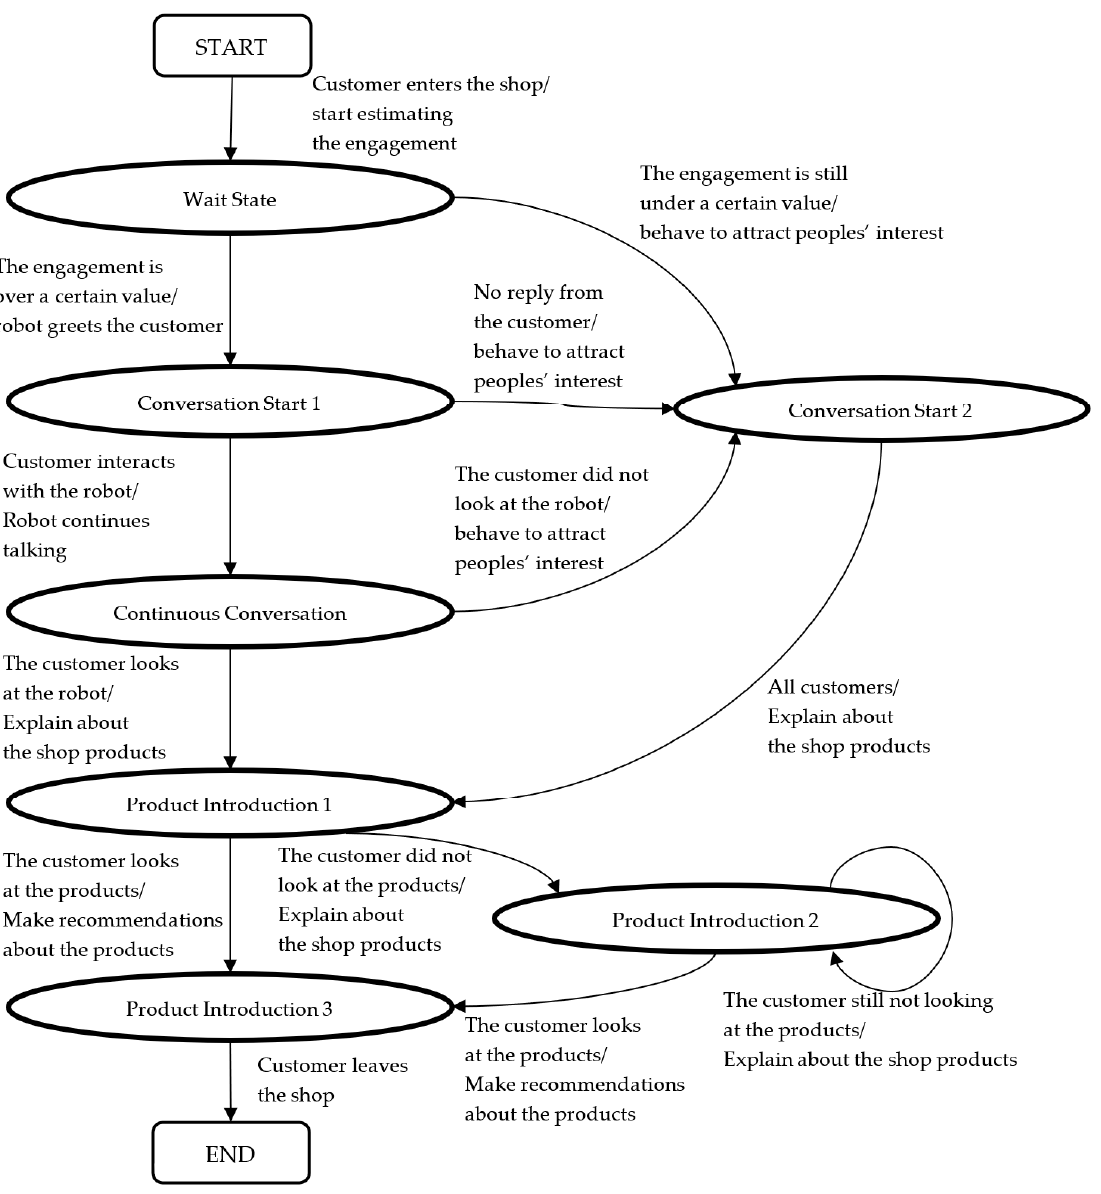
Figure 19. Abstracted state-transition model of interaction.